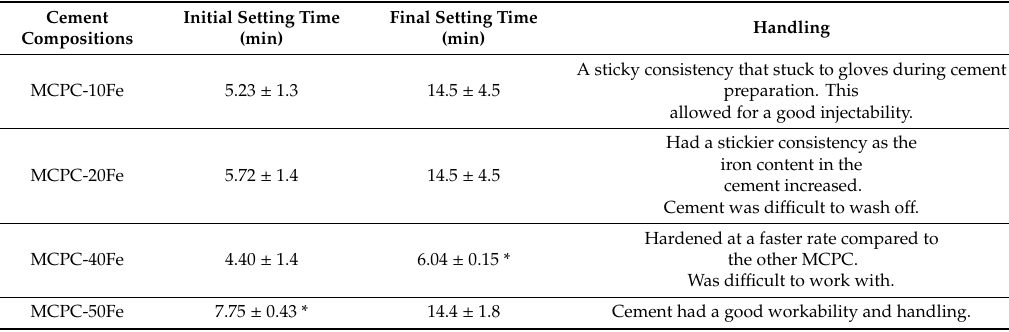
Table 2. Setting time of the di ff erent compositions of magnetic